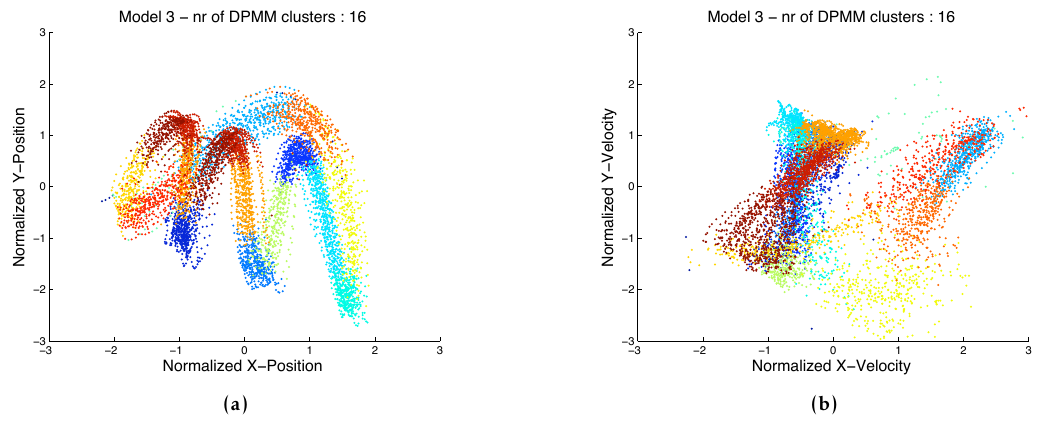
Figure 5. Cluster assignment (based upon positional coordinates and velocity